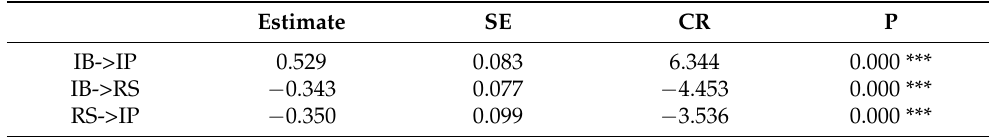
Table 4. Non-standardized regression